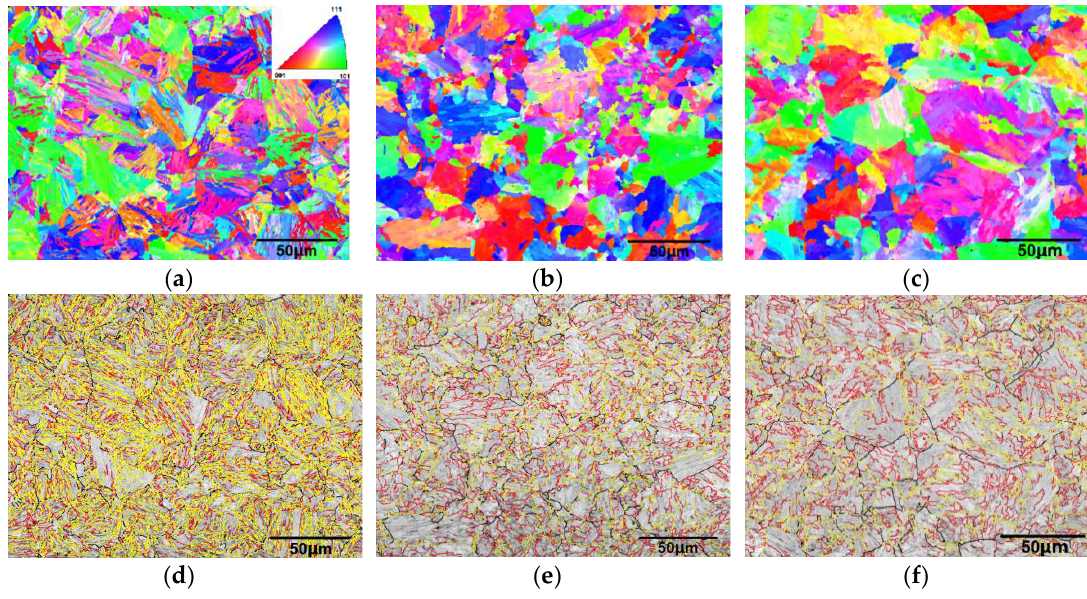
Figure 3. IPF (inverse pole figure) maps ( a – c ) and the corresponding boundary maps ( d – f ) (red line: 2° < θ < 15°, black line: 15° < θ < 45°, yellow line: θ > 45°) of a 130 mm-thick steel plate. ( a , d ) 0 t; ( b , e ) 1/4 t; ( c , f ) 1/2 t.